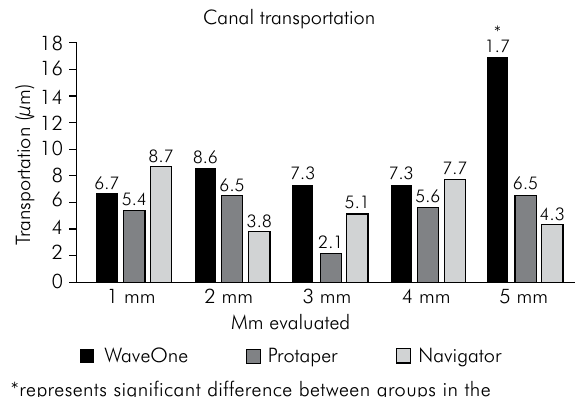
*represents significant difference between groups in the same-level section. Figure 1. Median of canal transportation (µm) in the WaveOne, ProTaper, and Wizard Navigator groups.